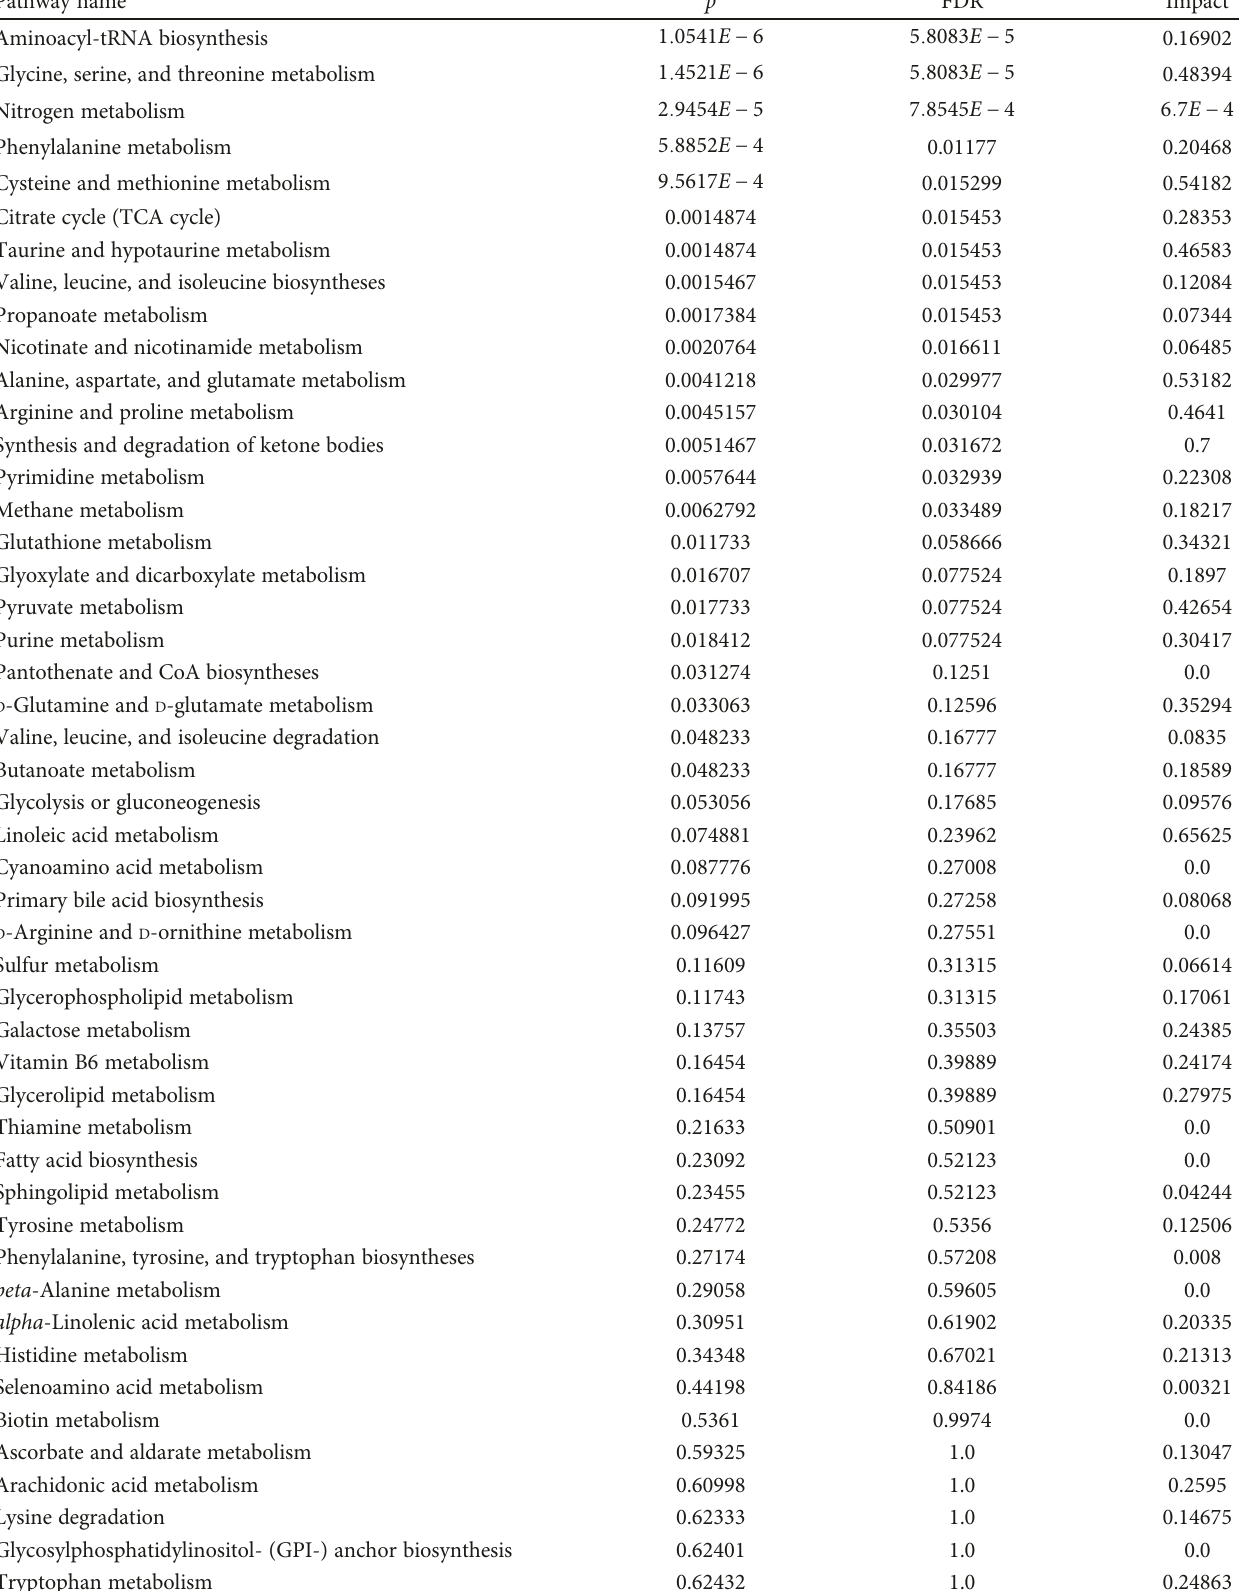
Table 2: The detailed results from the pathway